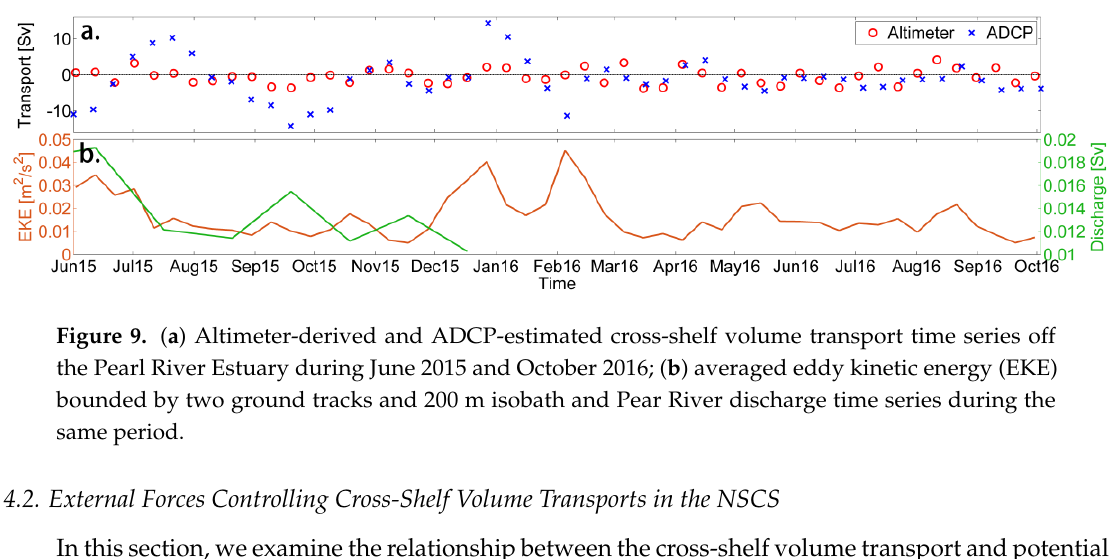
Figure 8. Seasonal cycles (left column) and interannual variabilities (right column) of cross-shelf volume transports across 200 m isobath near Dongsha Islands (CV088012), off the Pearl River Estuary (CV012190) and to the northeast of Hainan Island (CV190114). Positive and negative values represent offshore and onshore transports, respectively. Numbers of each control volume are shown in the upper left corner of right column panels.